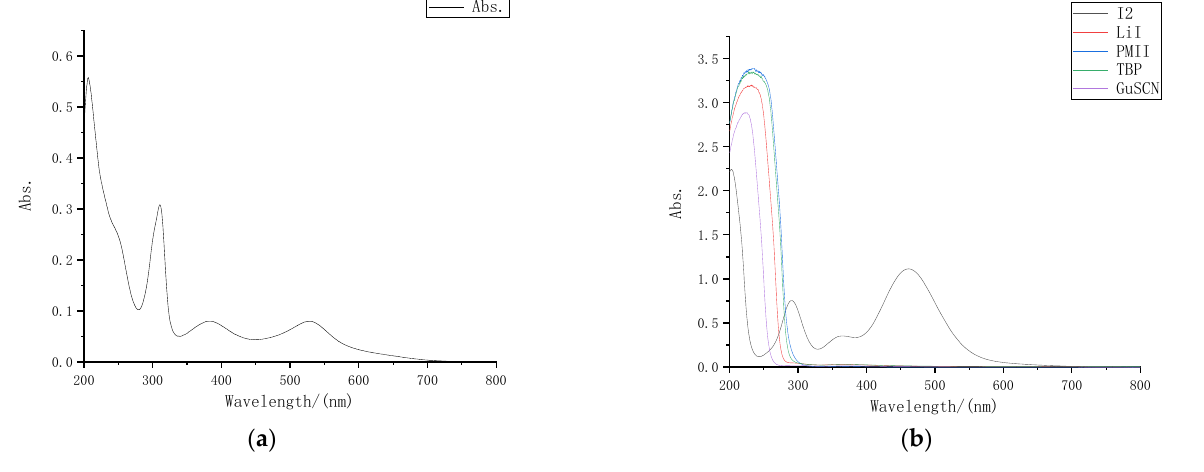
Figure 2. UV-VIS absorption spectrum: ( a ) UV-VIS absorption spectrum of N719 dye; ( b ) UV-VIS absorption spectra of different solutes.